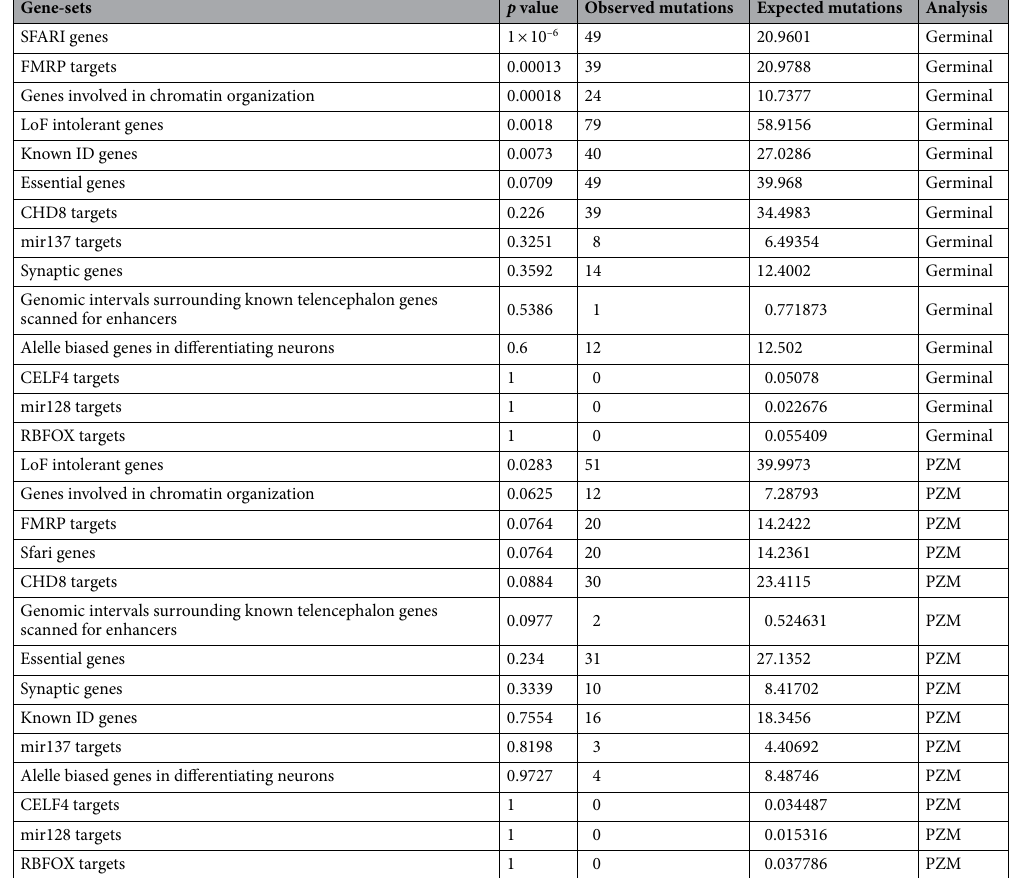
Table 3. Results of the gene-set enrichment analysis for the list of genes harboring germinal DNMs and PZMs (Spanish